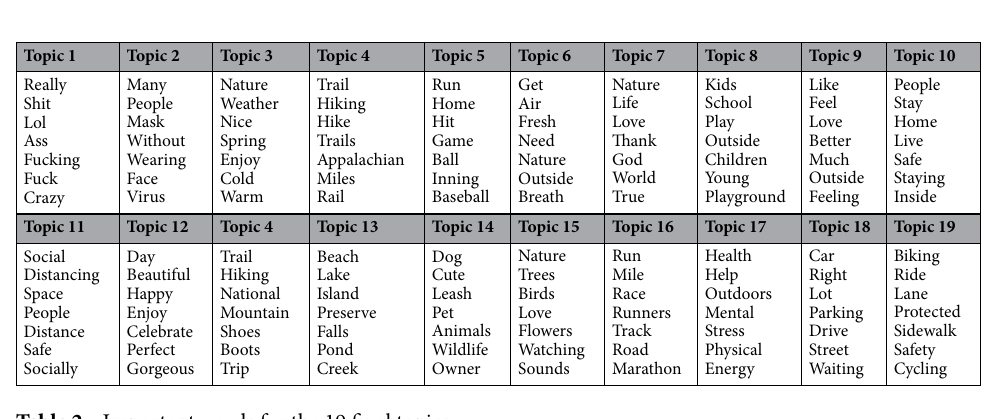
Table 2. Important words for the 19 final